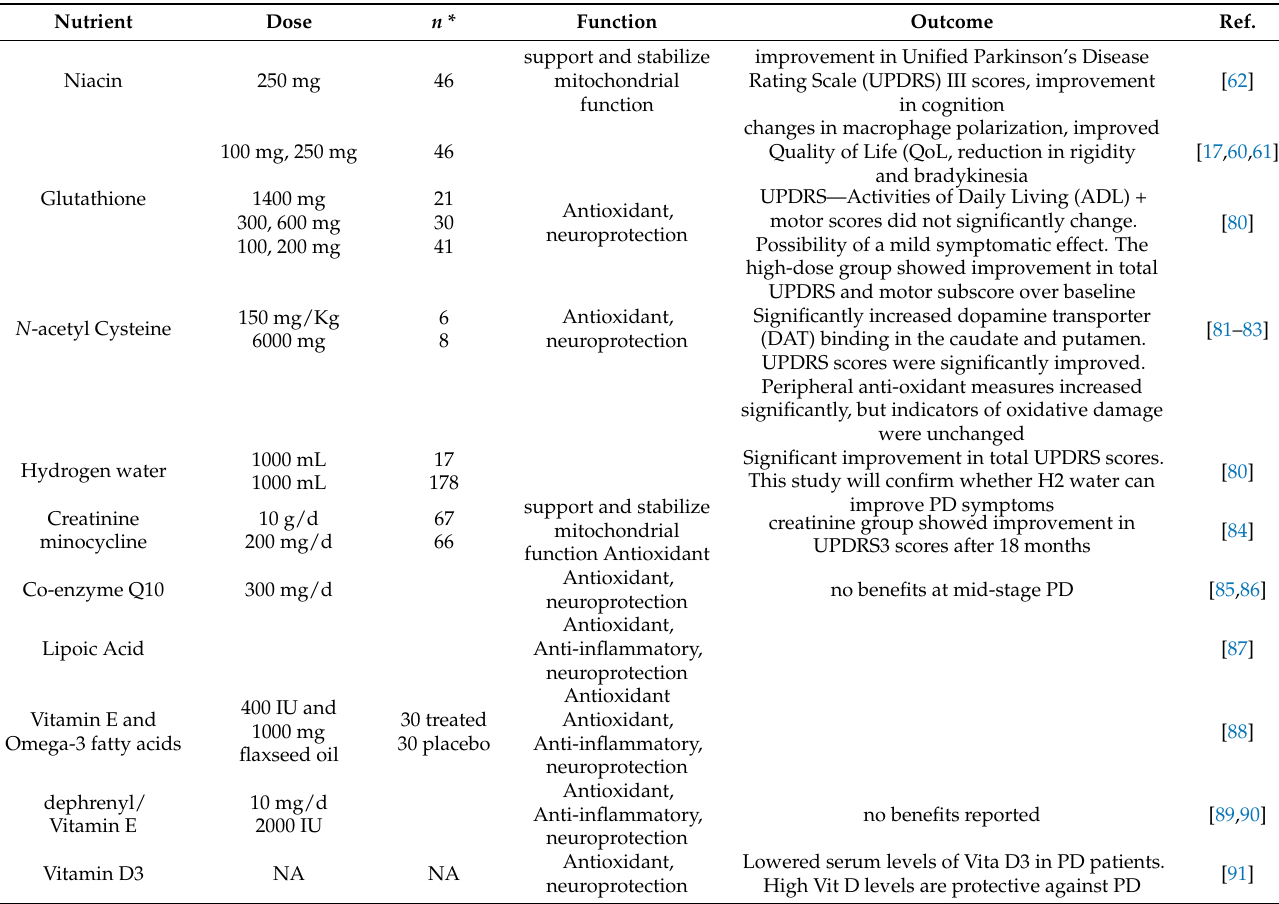
Table 2. List of nutrients that were tested in clinical trials with outcomes for